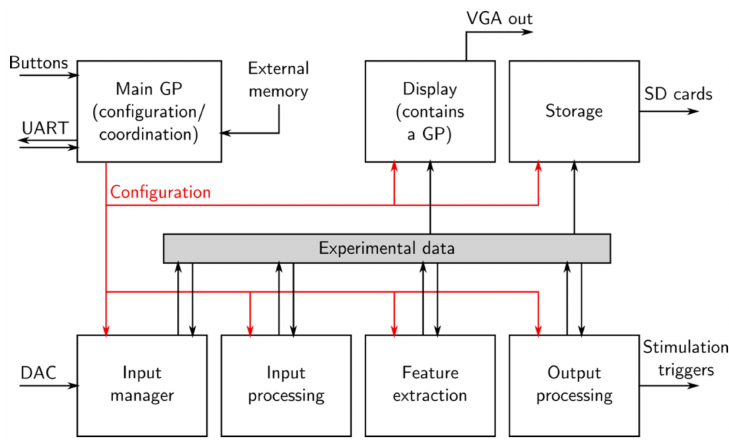
Figure 4. High-level data flow of Multimed. The generic processor (GP) is separate from the data processing chain and only helps as a means of communicating and configuring. All of the digital processing modules feed off the same data bus (Experimental data), minimizing dependencies and facilitating complex